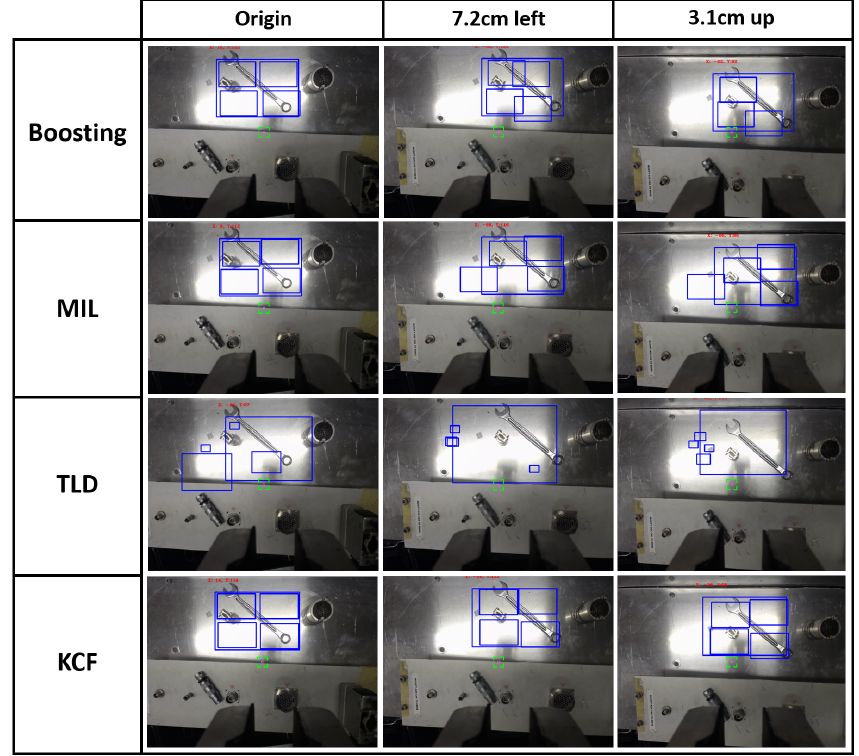
Figure 17. The performance of monitoring algorithms tested prior to system development, where it is shown the origin position, the translation in X , and translation in Y . Translations are with respect to the robot